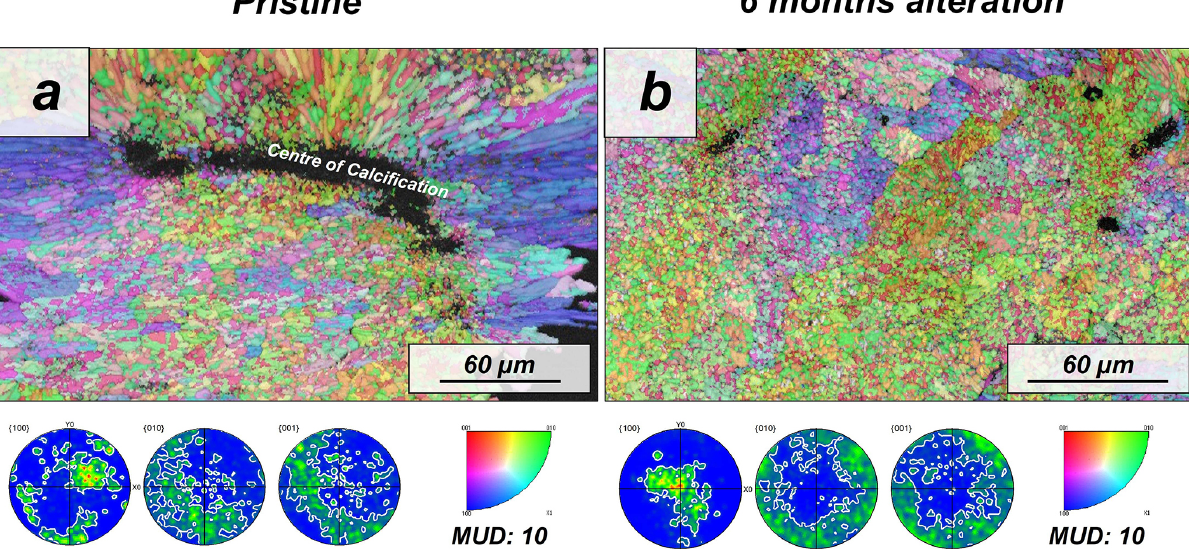
Figure 6. Colour-coded orientation maps with their corresponding pole figures derived from EBSD scans depicting the microstructure and texture of (a) pristine and (b) altered coral, Porites sp., skeletons. Crystal co-orientation is given by the MUD value. No major changes can be observed between the pristine and the altered skeletal elements. However, we do not discard that the alteration may have produced variations in the microstructure of Porites sp. that could not be detected by EBSD. The low co-orientation of the aragonite crystals in the pristine sample makes it difficult to see variations after